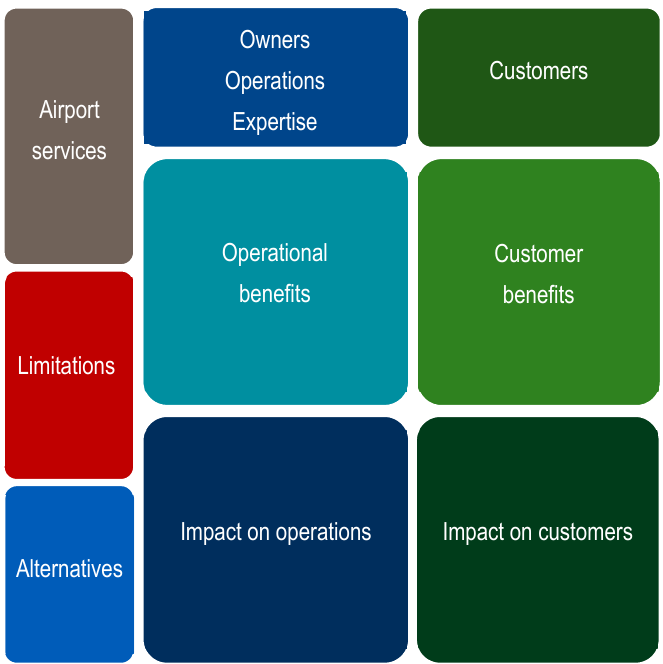
Figure 3. Framework for structuring discussion at the workshop.